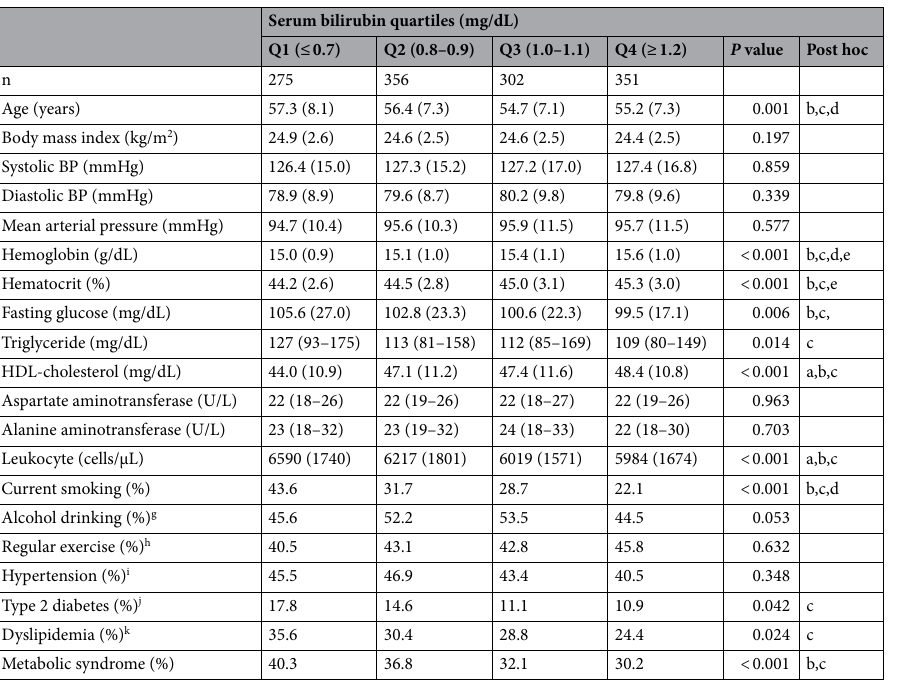
Table 1. Clinical characteristics of the study population according to serum bilirubin quartiles. BP blood pressure, HDL high density lipoprotein, NA not applicable. Data are expressed as the mean (SD), median (IQR), or percentage. P-values were calculated using 1-way ANOVA test, Kruskal–Wallis test, or chi-square test. The differences of mean, median and proportion between groups were determined using post hoc analysis of ANOVA, Kruskal–Wallis test and chi-squared test using Bonferroni corrections. a Q1 versus Q2, b Q1 versus Q3, c Q1 versus Q4, d Q2 versus Q3, e Q2 versus Q4, f Q3 versus Q4, g Alcohol drinking ≥ twice/week.